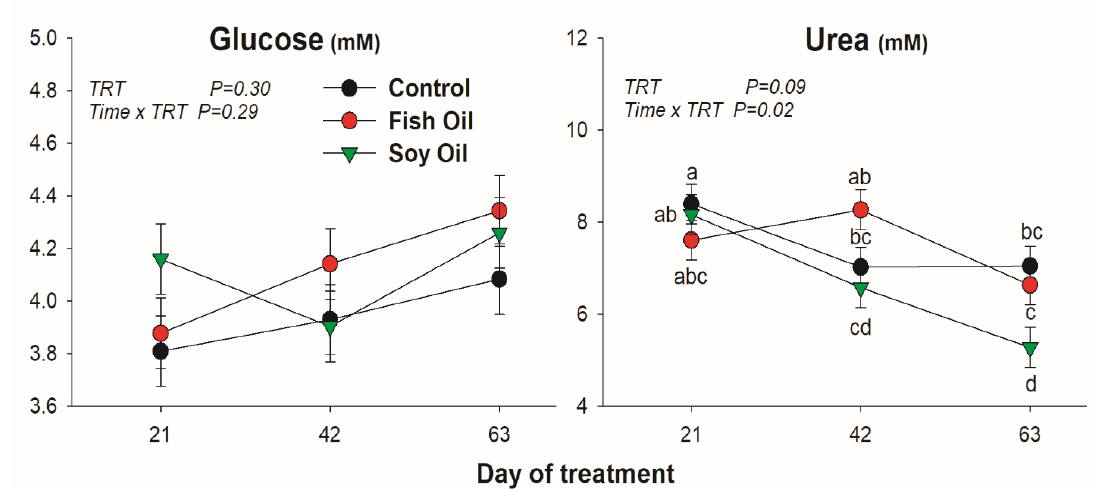
Figure 2. Effect on plasmatic concentration of glucose and urea by long-term supplementation of lactating dairy cows (n = 5/group) with soybean oil or fish oil. The p -value of the overall treatment (TRT) and TRT × Time interaction is reported. Data were corrected for the baseline before statistical analysis. Bars denote standard error of the means.